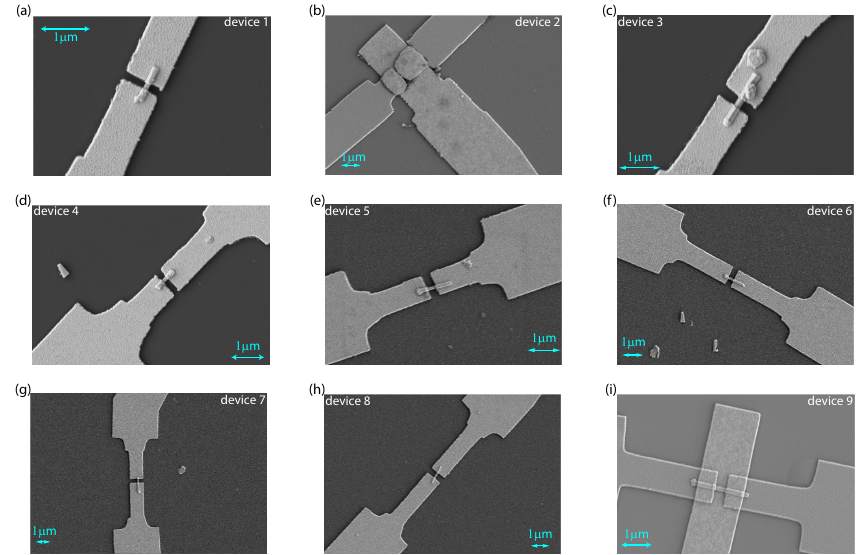
Figure S1: Scanning electron microscope images of all devices used in this paper. (a) device 1, used in Figs. 2 and 3 before fabrication of the topgate, (b) device 2, liftoff issues with topgate made nanowire hard to see, (c) device 3 before fabrication of the topgate, (d) device 4, (e)-(h) backgate chip, devices 5-8; (i) device 9, used for Fig.